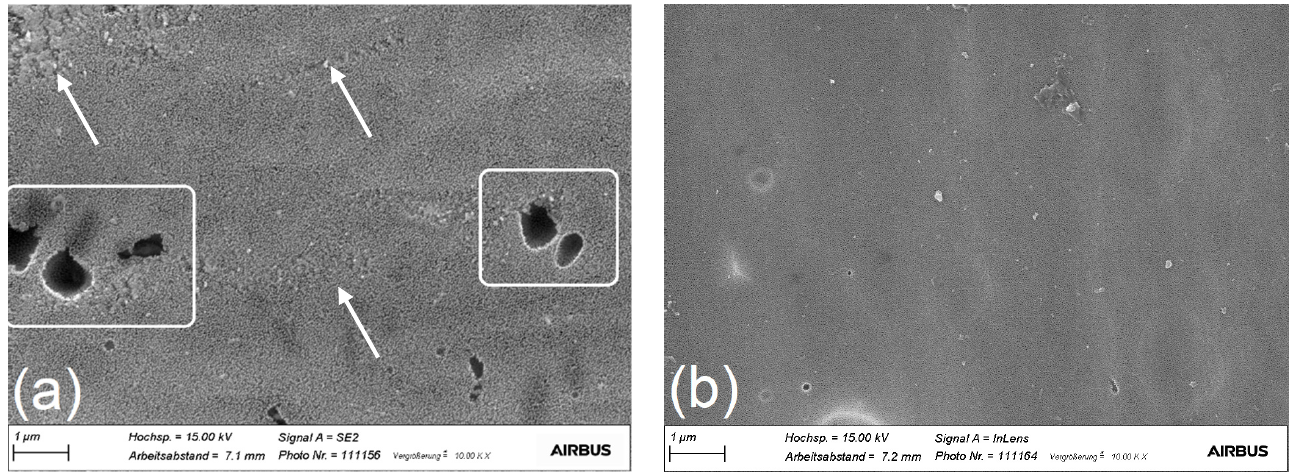
Figure 12. FE-SEM Images of ( a ) SAA 20 V 37 °C and ( b ) TSA 20 V 37 °C after 16 h of immersion in a pH 3 dilute Harrison’s solution. The marked areas in figure ( a ) correspond to defects in the anodic film due to immersion in the aggressive acidic solution.